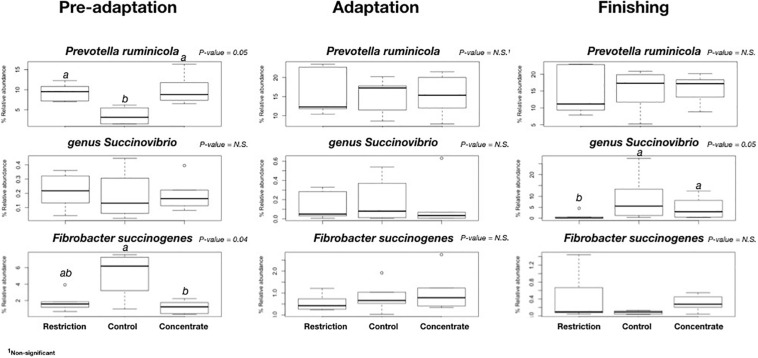
Comparison of relative abundances of bacterial species found to be significantly different in all cannulated Nellore cattle during pre-adaptation (day 5), adaptation (day 16), or finishing (day 27). Only those OTUS with on average ≥ 1% sequence abundance in each animal were considered in this comparison. a,bFor treatment effect, within a row means without common superscript letter differ (P < 0.05).